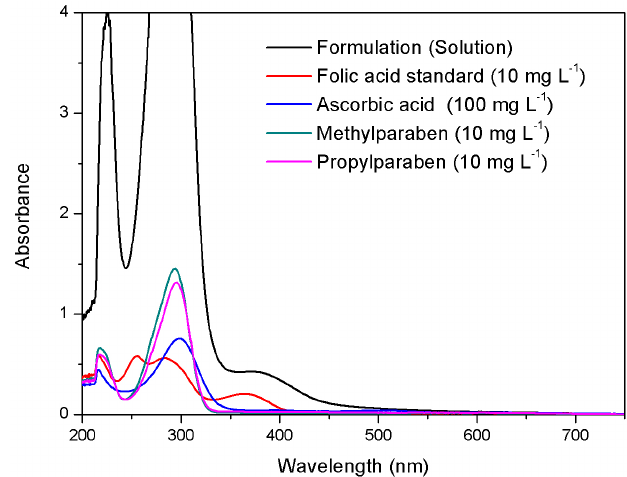
FIGURE 5 - Comparison of zero order spectra for 10 mg L -1 folic acid and the main excipients used in the solution formulation.